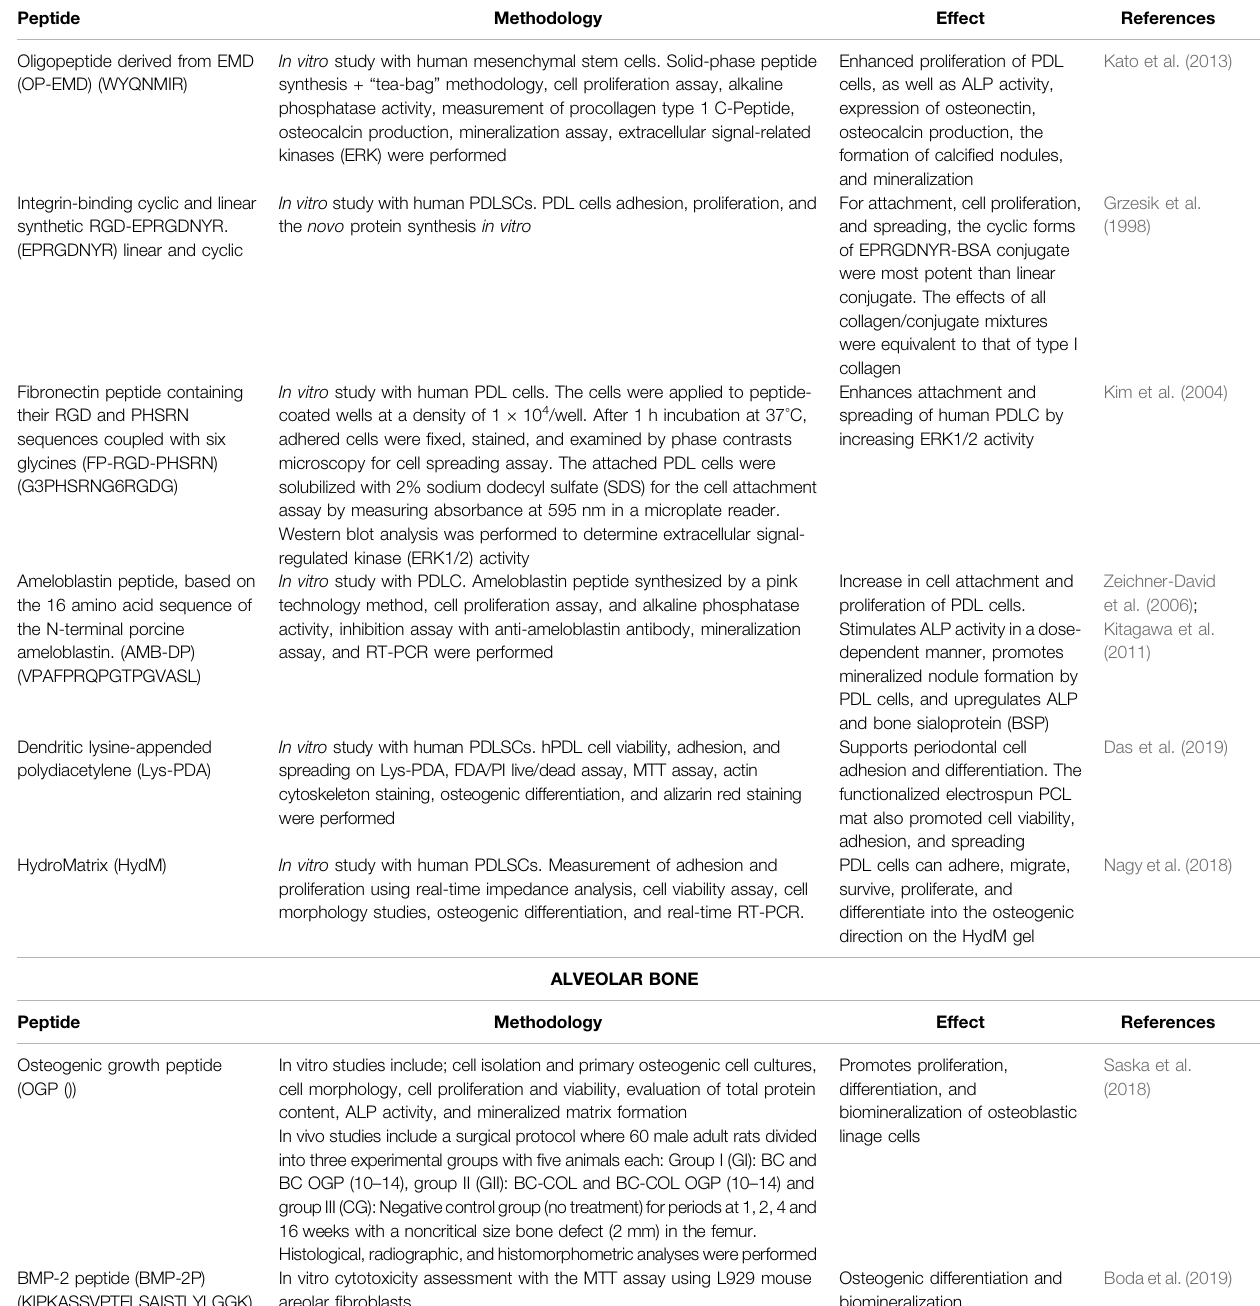
TABLE 2 | Synthetic peptides used in periodontal tissues